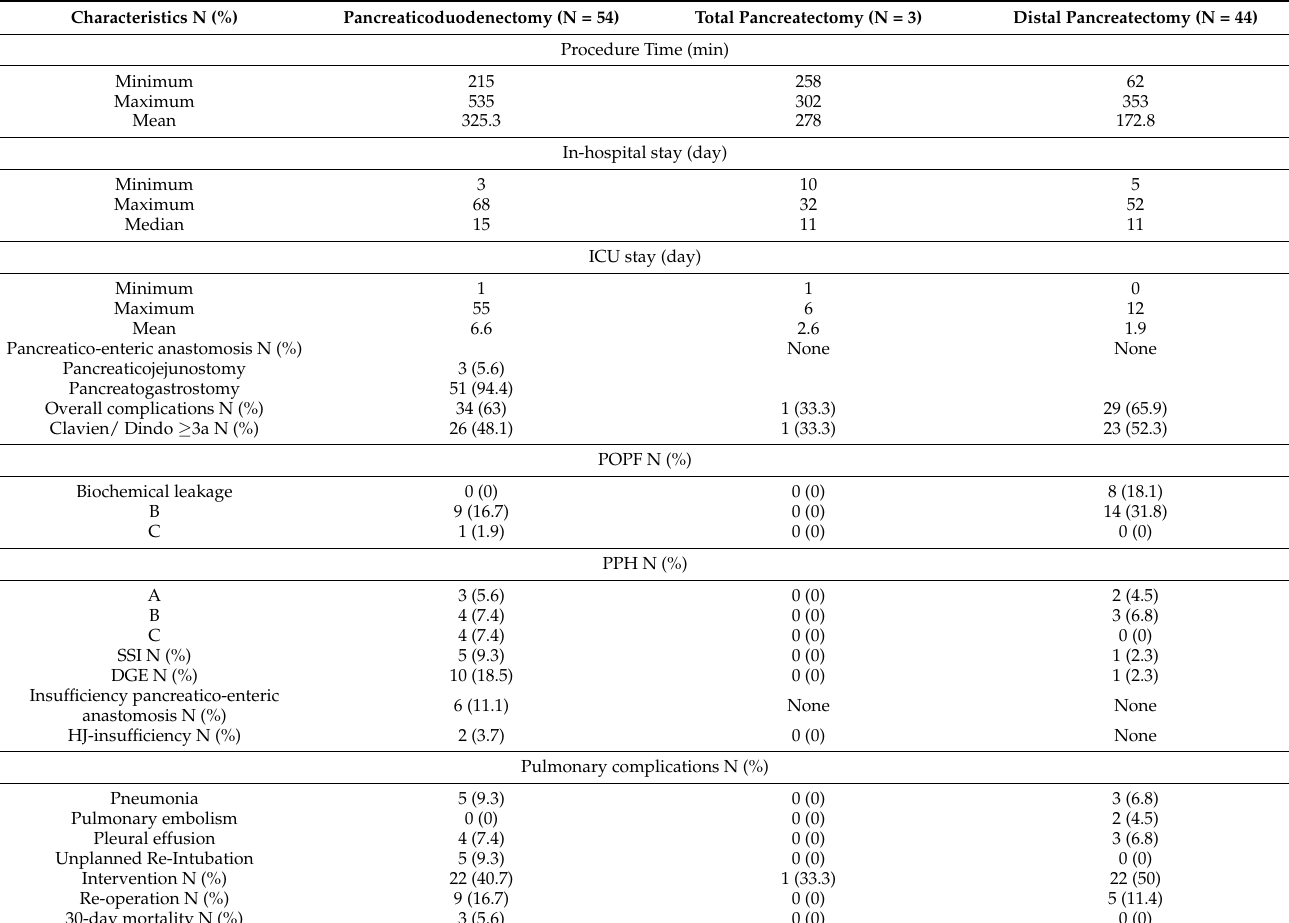
Table 2. Perioperative